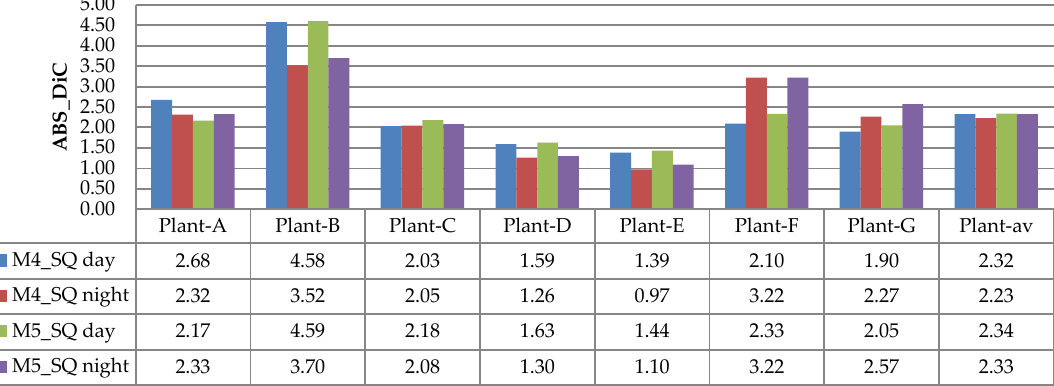
Figure 21. Results of ABS_DiC measurements using the NoIR camera.